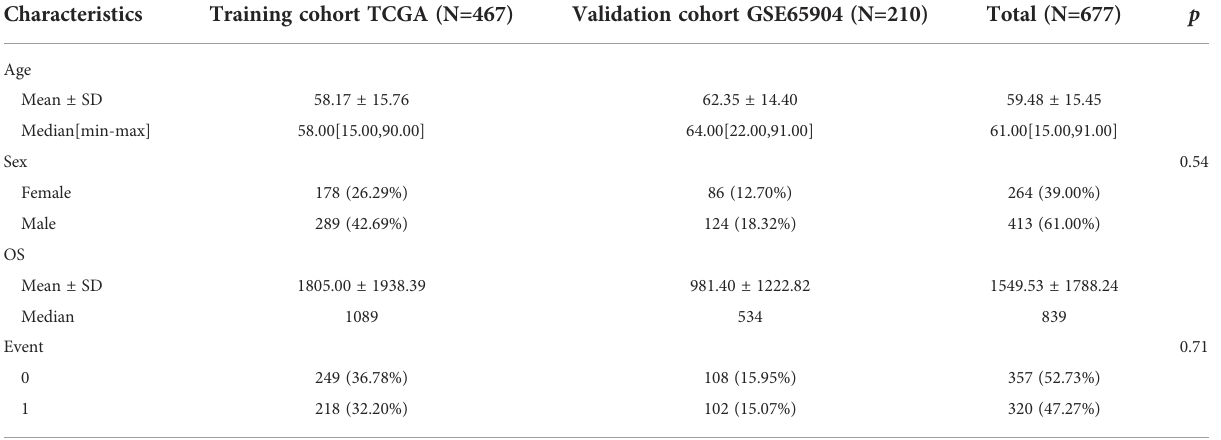
TABLE 1 Data source and clinicopathologic characteristics of patients.